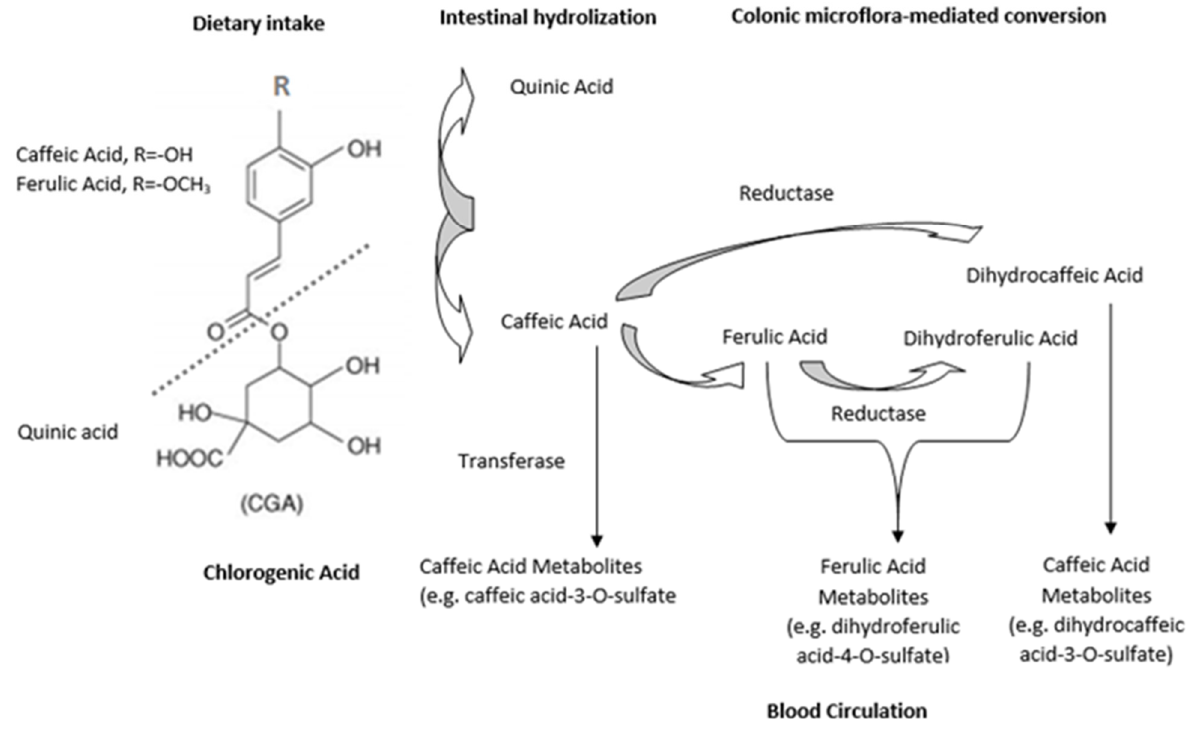
Figure 3. The major metabolic pathway of CGAs.